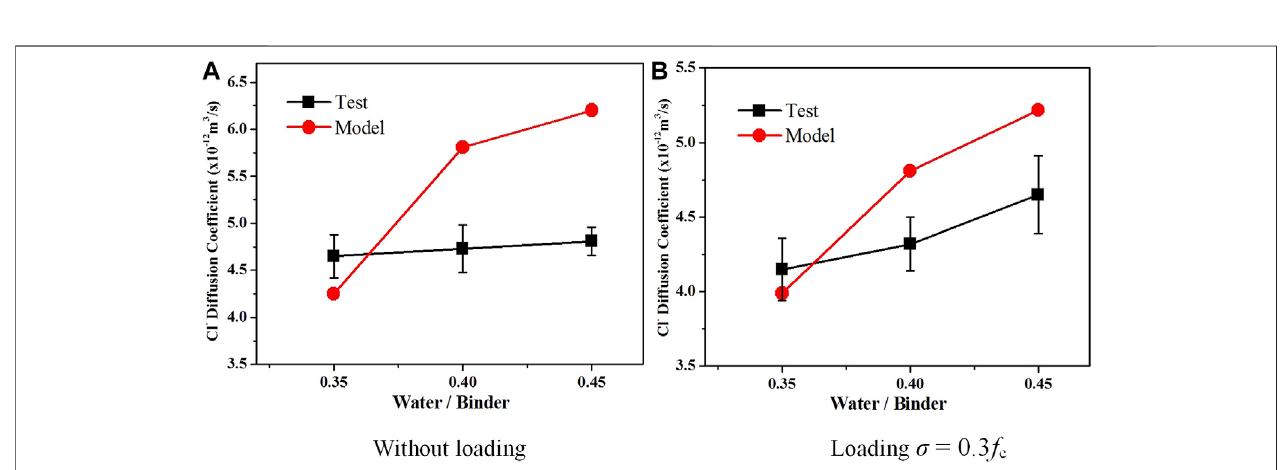
FIGURE 8 | Chloride diffusion coef fi cient of concrete immersed for 30 days.